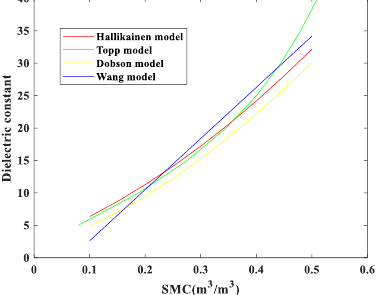
Figure 12 . The four soil models on international clay loam （ C=0.2 ， S=0.33 ） .